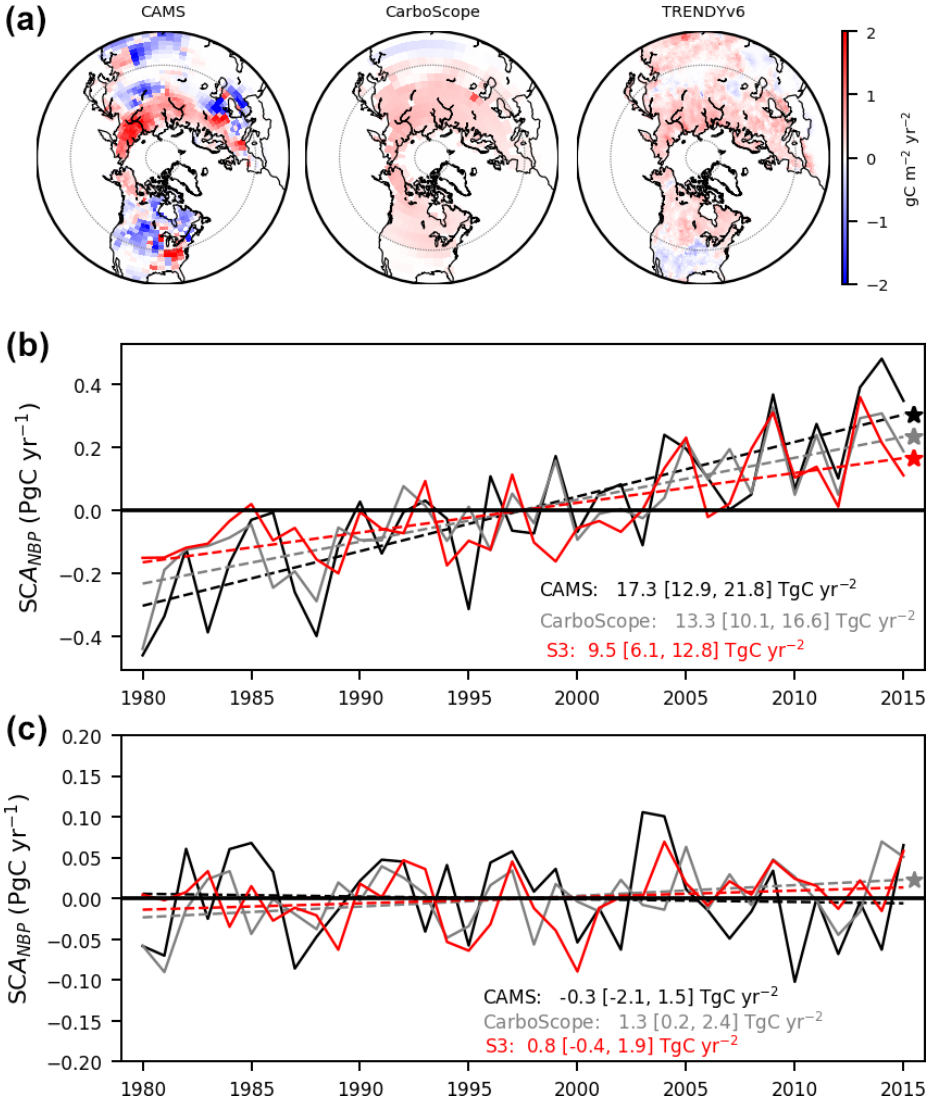
Figure 1. Variability in seasonal-cycle amplitude and trends from the inversions and LSMs. (a) Geographical distribution of SCA NBP trends from the inversions (CAMS and CarboScope) and the multi-model ensemble mean (MMEM) from TRENDYv6 simulation S3 (all forcings). Both inversions estimated predominantly positive trends in SCA NBP > 40 ◦ N (Fig. S1), so we defined two latitudinal bands, L > 40N and L 25 − 40N , for flux aggregation. (b, c) Aggregated SCA NBP time series estimated by the inversions (CAMS in black and CarboScope s76 in grey) and S3 MMEM (red) for L > 40N and L 25 − 40N , respectively. The dashed lines indicate the linear fits used to calculate the slopes of the trends (corresponding colours), and the slopes and confidence intervals (95%) are